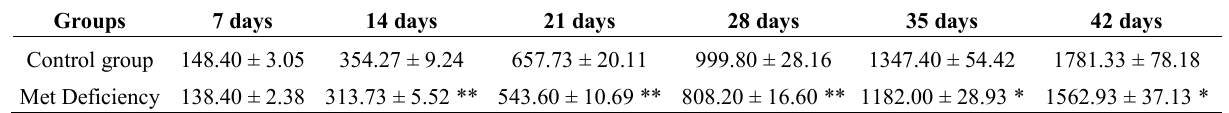
Table 1. Effect of Met deficiency on the body weight (g) of